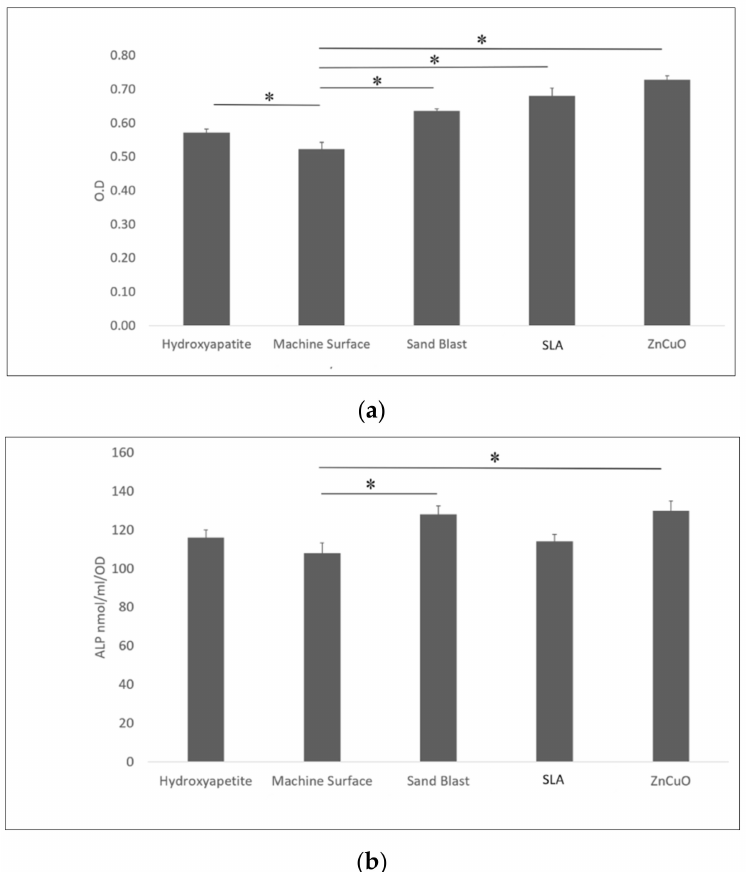
Figure 5. Osteoblast-like cells seeded in culture wells on machined, sandblasted, SLA, and ZnCuO-coated titanium surfaces and hydroxyapatite discs, after 48 h incubation: ( a ) cell proliferation (XTT assay); ( b ) alkaline phosphatase (ALP) activity, expressed as the mean + SD ( n = 9; asterisk indicates p < 0.05). Macrophage-like cell proliferation (XTT assay) was significantly higher on the sand- blasted and hydroxyapatite surfaces than on the machined surface (1.16- and 1.23-fold, respectively) (Figure 6a). TNF- α cytokine production was significantly higher in cells cultured on the sandblasted surface compared with the hydroxyapatite, machined, SLA, and ZnCuO-coated surfaces (1.1-, 1.07-, 1.3-, and 1.15-fold, respectively) (Figure 6b).